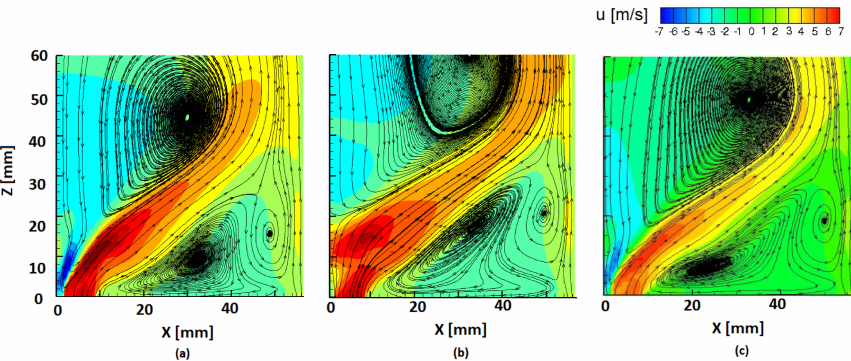
Figure 15. Flow comparisons-axial velocity profile shown for FGM premixed and different turbulence models: ( a ) RNG k- (cid:101) , ( b ) k- ω and ( c )